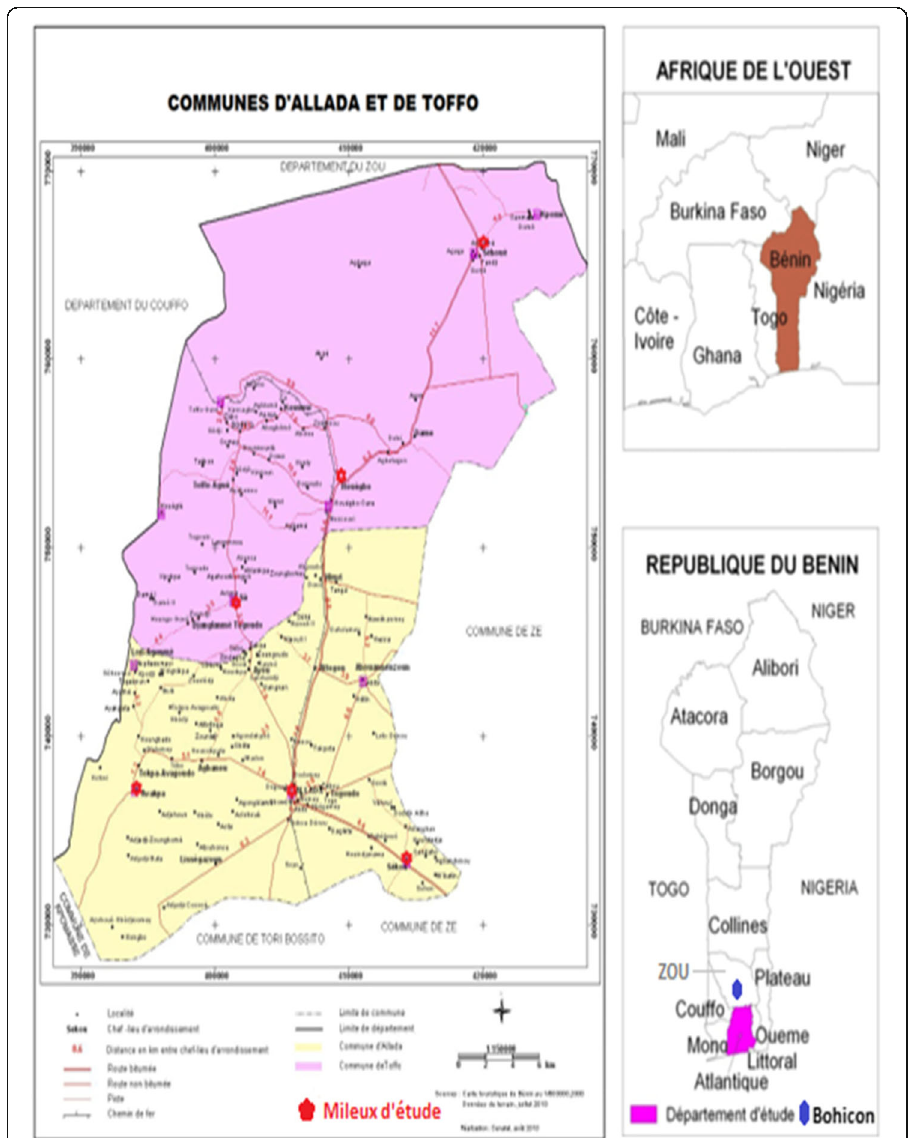
Fig. 1 Map of Benin. Study districts with location of study